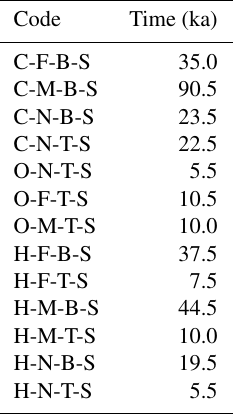
Table 4. Time to reach a steady state for all equivalent steady-state